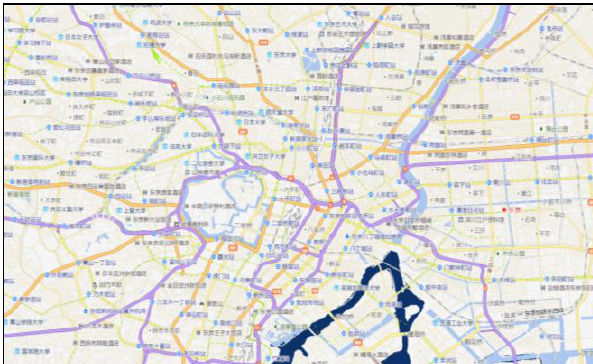
Figure 7 . Map service based on fused road network